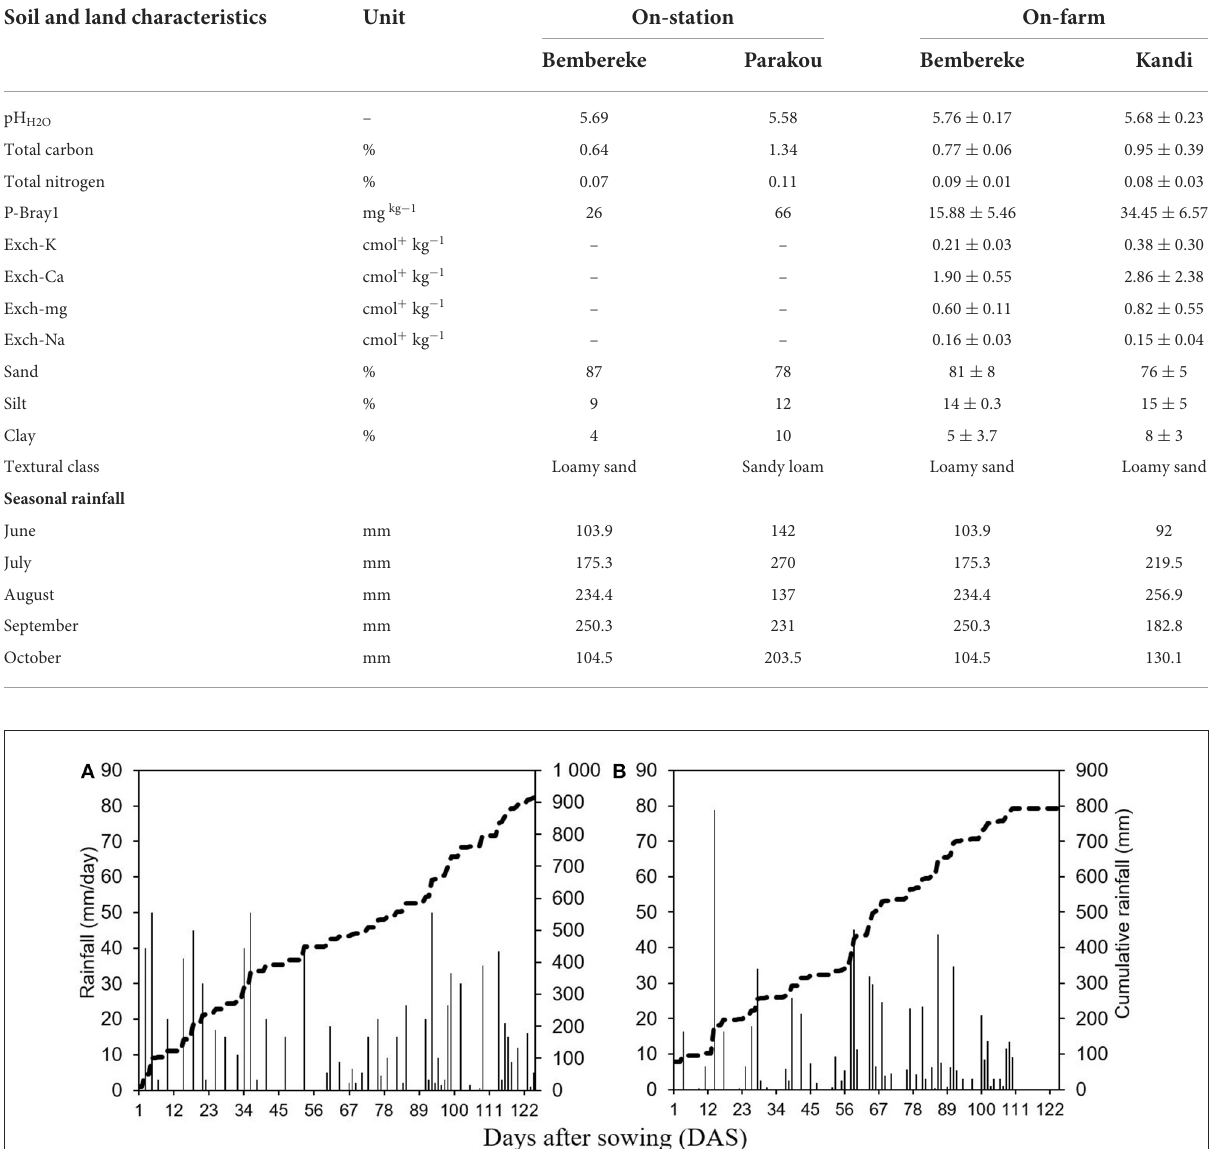
TABLE 3 Physico-chemical characteristics of the soil at experimental sites.